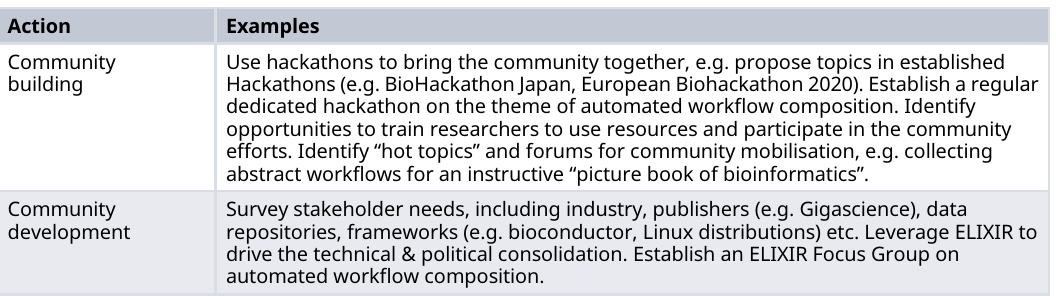
Table 4. Future work on